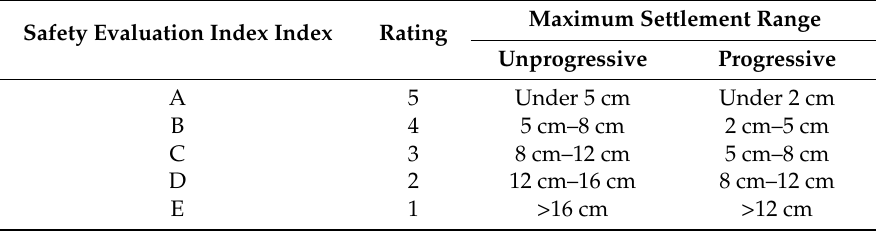
Table 8. Safety Evaluation Index (SEI) for the FBG displacement